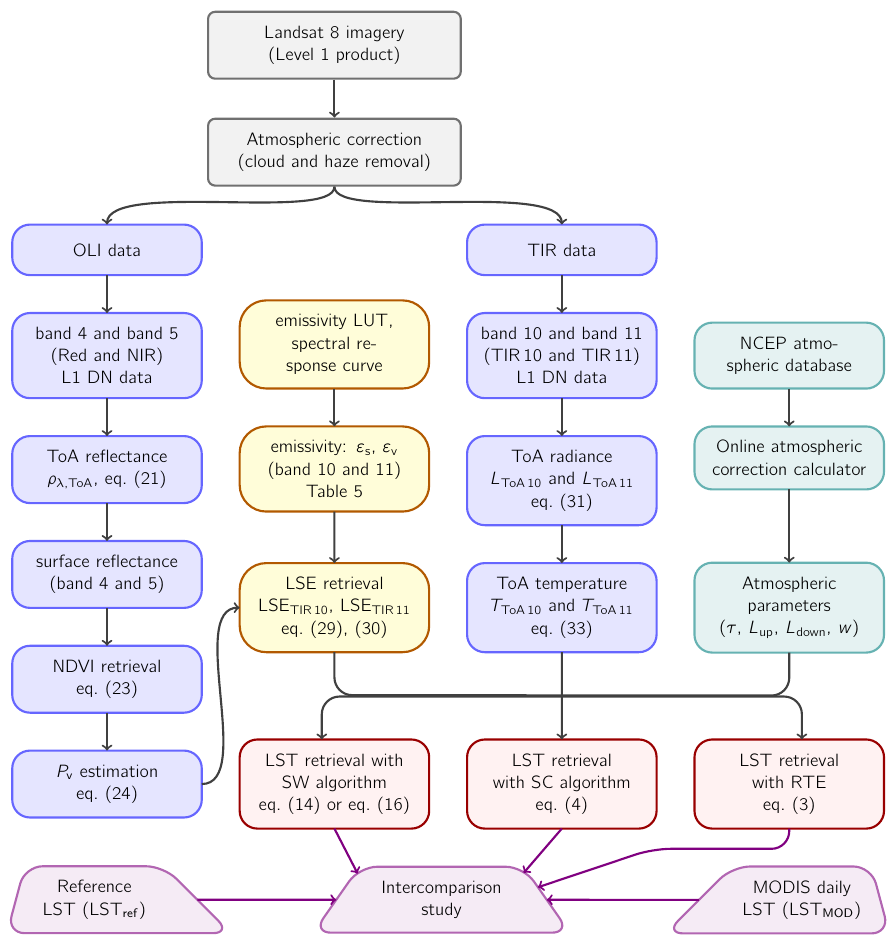
Figure 2. Algorithm flowchart for Land Surface Temperature (LST) retrieval with four methods and their intercomparison study from Landsat 8 thermal infrared (TIR) data. OLI = Operational Land Imager; LUT = Look Up Table ; DN = Digital Number; NDVI = Normalized Difference Vegetation Index; SW = Split-Window; NCEP = National Centers for Environmental Prediction; ToA = Top-of-Atmosphere; NIR = Near-Infrared; LSE = Land Surface Emissivity; SC = Single-Channel; TIR = Thermal